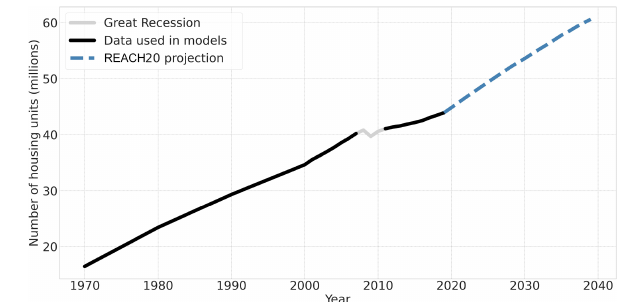
Figure 5. Average percent relative error for each county over all predicted time steps and samples, E i [| H |] , for the combined train- ing and testing set using the REACH20 model. Given that the sam- ples for a given county and time sequence were randomly split into the training and testing set, a spatially complete view of the errors required a combination of the training and testing errors.